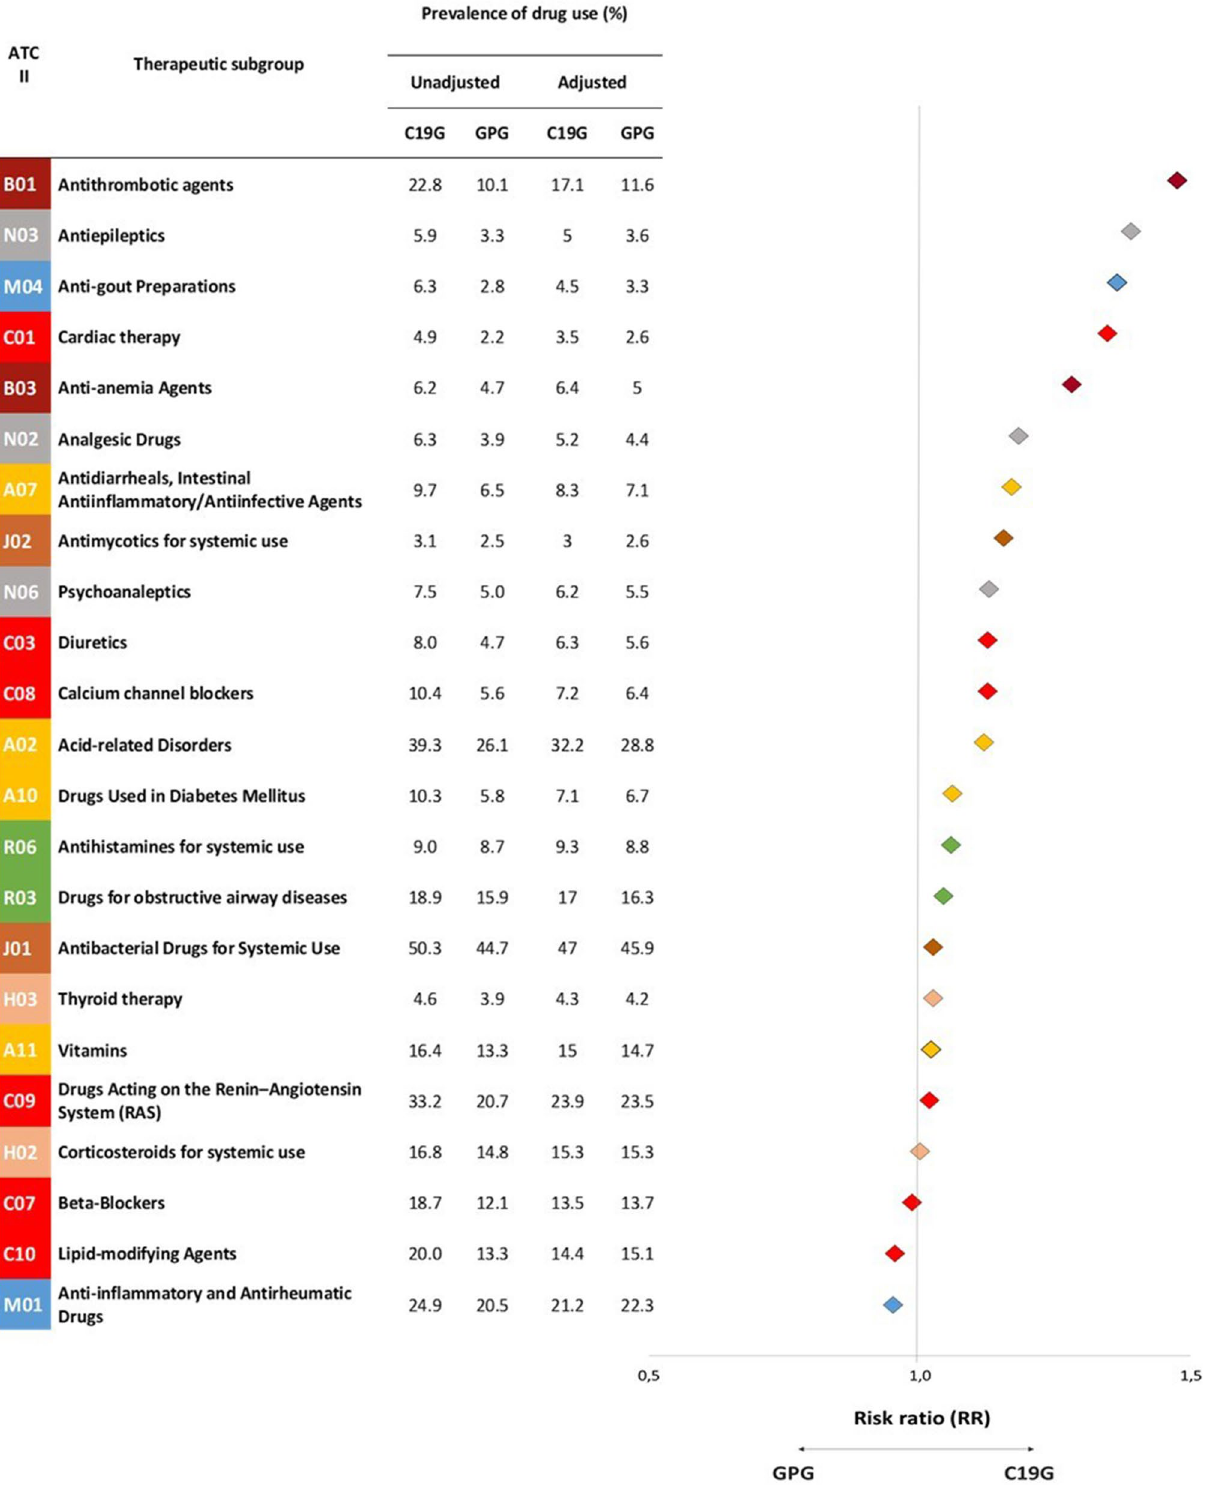
Figure 1. Differences in prevalence of drug use between the C19G and GPG according to Therapeutic Group (ATC II). C19G COVID-19 group; GPG general population